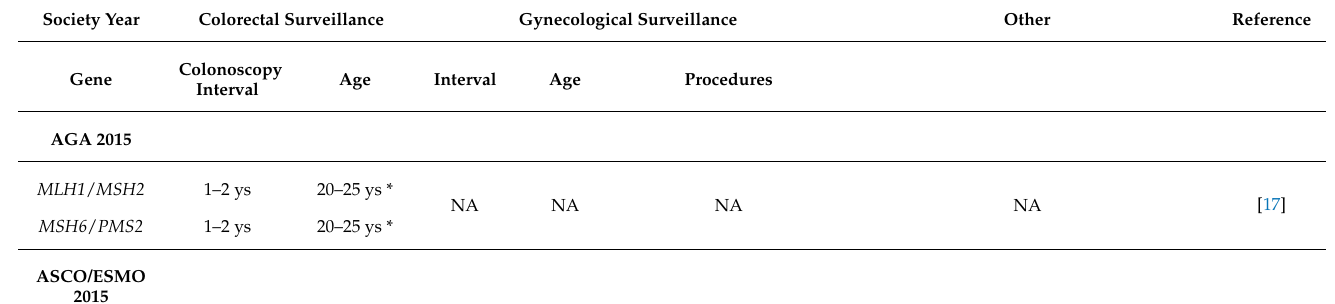
Table 2. The recent guidelines of surveillance strategy in Lynch syndrome